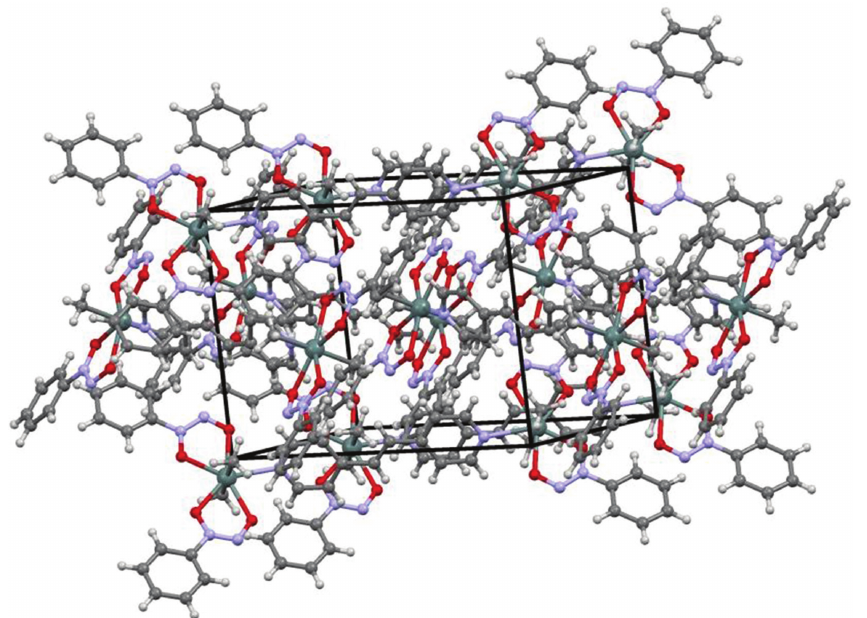
Figure 2: Crystal packing in 1.